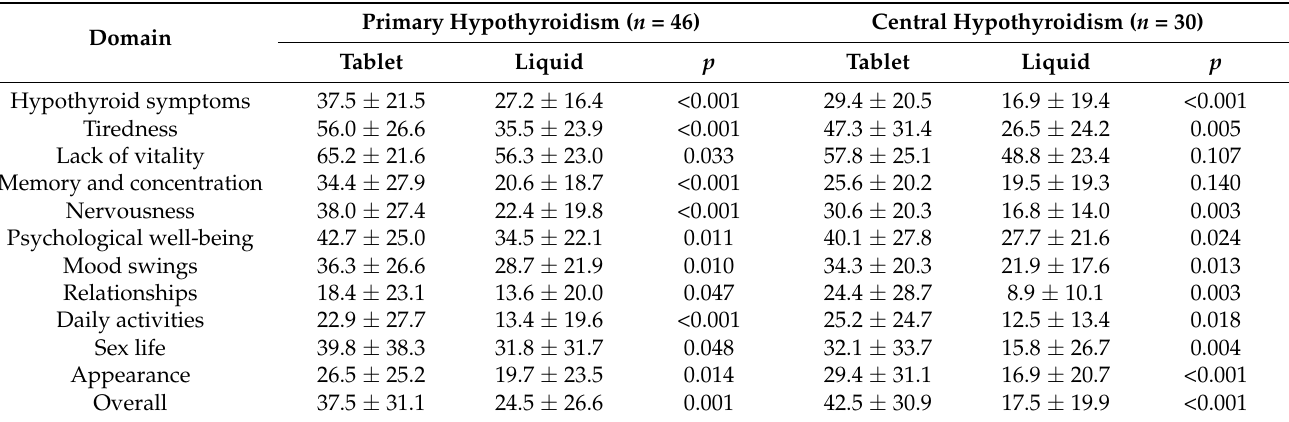
Table 2. Comparison of QoL (ThyPROpl) between LT4 therapy in tablet and liquid form in an equivalent dose in primary and central